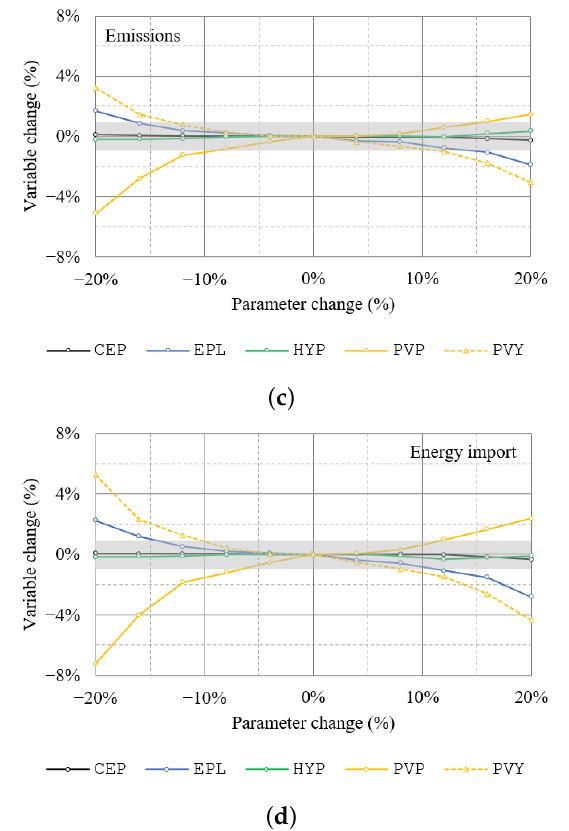
Figure 12. Effects of parameter changes to respective variables; Grey areas indicate a ± 1% in- significant region; CO 2 emission price ( CEP ), electricity price ( EPL ), hydrogen price ( HYP ), PV prices ( PVP ) and PV yield ( PVY ). ( a ) Total costs; ( b ) Optimal PV installed capacity; ( c ) Total CO 2 emissions; ( d ) Energy